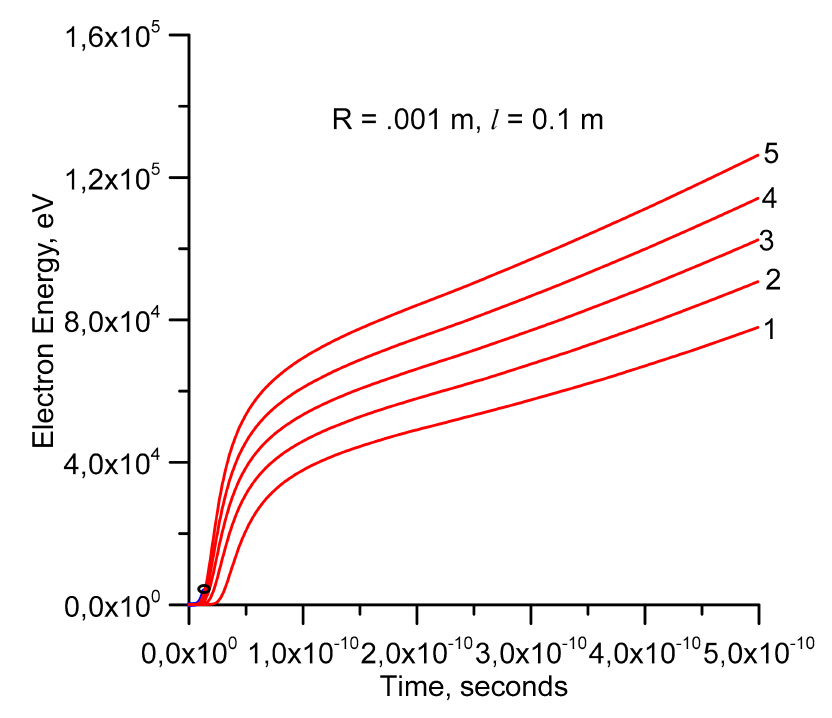
Figure 7. The effect of the speed of propagation of the ionization wave, v, of the wave on the energy gained by electrons for an ionization wave of radius 0.001 m and length 0.1 m. (1) v = 10 × 10 6 m/s (2) v = 1.5 × 10 7 m/s (3) v = 2.0 × 10 7 m/s (4) v = 2.5 × 10 7 m/s (5) v = 3.0 × 10 7 m/s. The waveform that terminates at the point marked with a circle corresponds to the speed 3.248 × 10 7 m/s. At this speed, the electron was engulfed by the ionization wave (at the time corresponding to the circle in the plot) before it had enough time to reach a speed comparable to the speed of the ionization